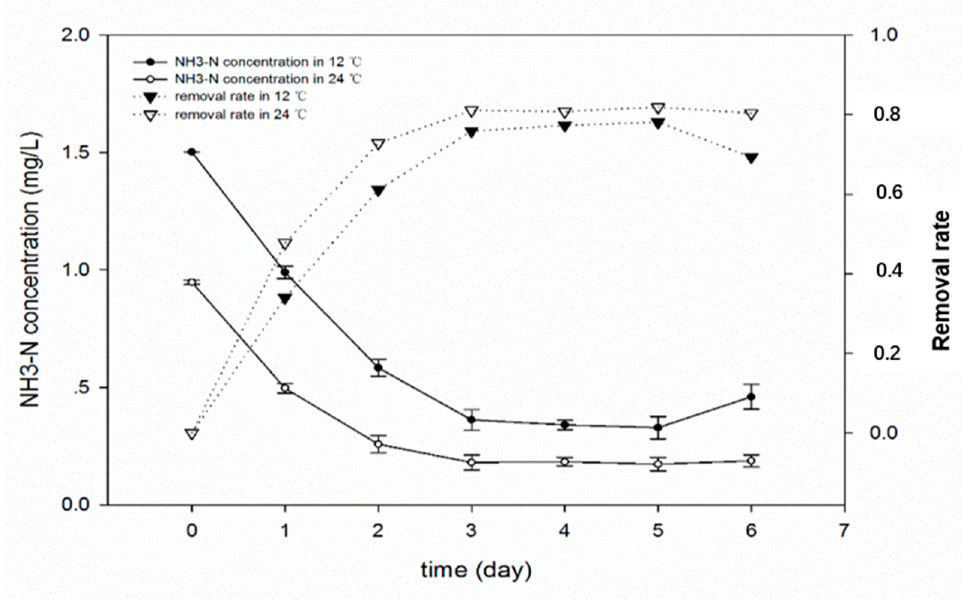
Figure 9. Removal of NH 3 –N at different temperatures.